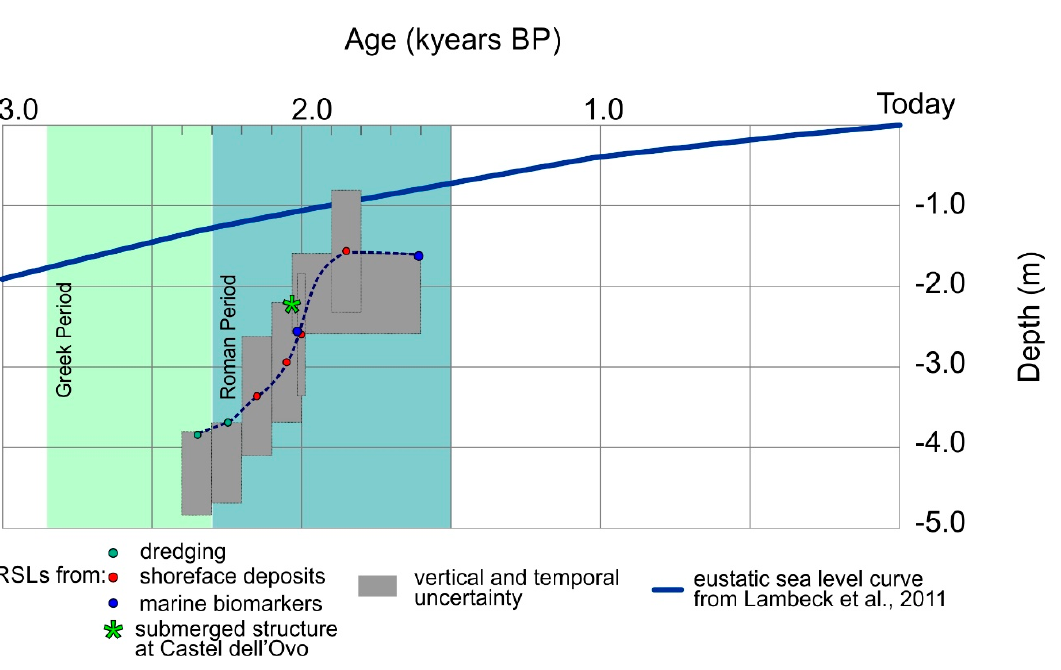
Figure 17. Chart of the relative sea level (RSL) variation in the near sector of Neapolis harbor and the RSL deduced by the fish tank related to the maritime villa at Castel dell’Ovo.